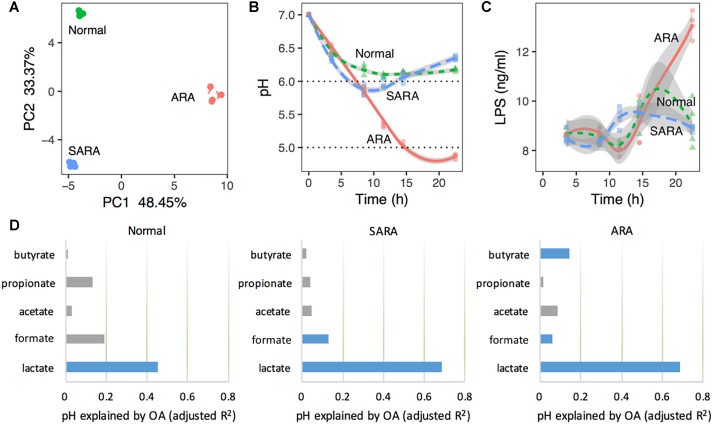
Rumen acidosis models (RAMs) can be induced by substrate starch abundance in mixed culture. (A) Principal component analysis (PCA) based on pH, bacteria relative abundance, organic acids concentration, LPS, and enzymes’ activity. (B) pH shifts in RAMS. (C) LPS concentrations at different sampling time points in RAMs. (D) Variation of pH explained by organic acids’ concentration in RAMs with model: pH ∼ lactate + formate + acetate + propionate + butyrate. Blue bars are statistically significant (P < 0.05). The x-axis represents the variance explained by organic acids. The total variance is 1.